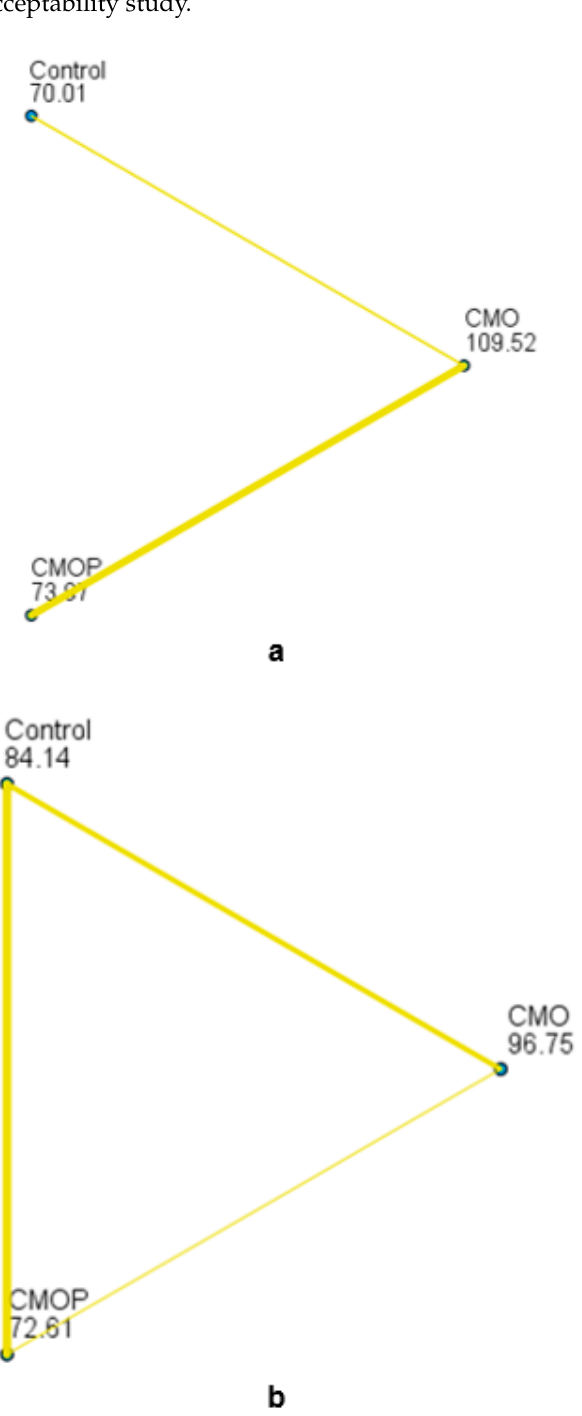
Figure 4. Paired comparison of the samples. Each node shows the sample average rank for ( a ) colour and ( b ) texture of the CMO (Citric acid + Moringa oleifera leaf powder), CMOP (Citric acid + Moringa oleifera leaf powder + potassium sorbate) and control dried sliced apples.